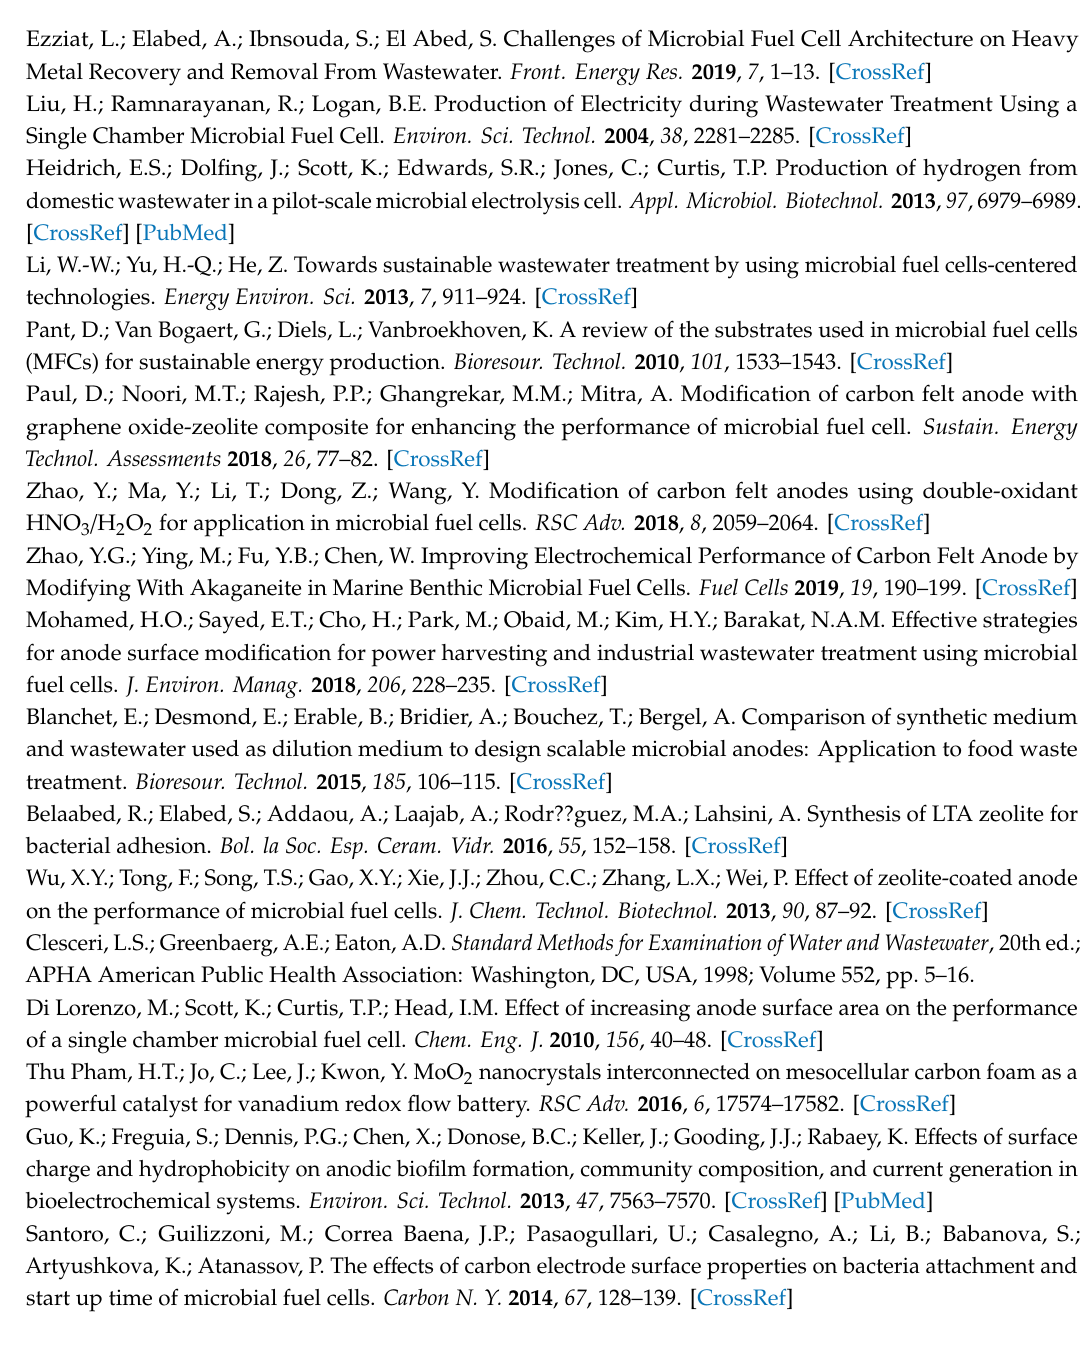
Table S1: Characteristics of unmodified and modified carbon felts; Figure S1: Variation of the current density on carbon felt electrodes polarized at − 0.2 V vs. SCE in tannery wastewater and 20 mM of acetate inoculated with acclimated activated sludge (dotted line) or non-acclimated activated sludge (solid gray